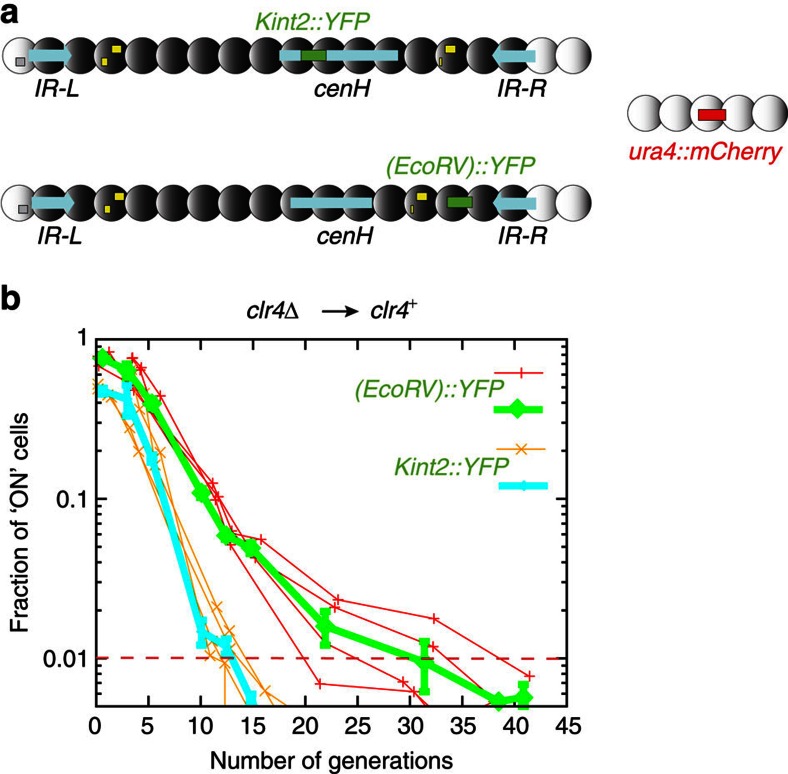
The kinetics of heterochromatin establishment are faster within cenH than outside cenH.(a) Location of the kint2::YFP and (EcoRV)::YFP reporters used in the experiment. These reporters are also shown in Fig. 2. (b) Establishment of heterochromatic silencing at kint2::YFP and (EcoRV)::YFP in re-introduction experiments, starting at the first division following re-introduction of clr4+. Fluorescence intensity was measured in microcopy images sampling liquid cultures at the indicated time point. The experiment was conducted in quadruplicate (thin lines) and the data were binned (thick lines). Error bars represent the s.d. of the values in each bin.